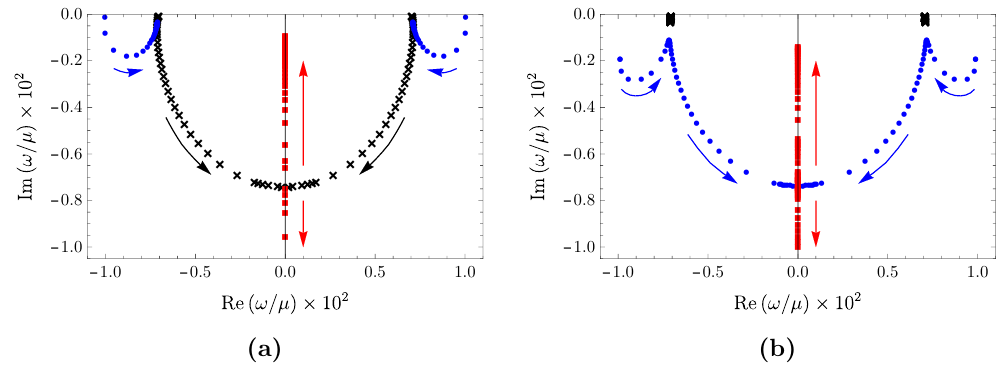
Figure 3. Positions of poles of G J and G tt in the complex !=(cid:22) plane for increasing T=(cid:22) , with ~ (cid:11) = 1 and k=(cid:22) = 10 (cid:0) 2 . We have enhanced Re ( !=(cid:22) ) and Im ( !=(cid:22) ) by 10 2 for clarity. The arrows indicate the movement of poles as T=(cid:22) increases. (a) (cid:28) = 0 and 5 (cid:2) 10 (cid:0) 4 (cid:20) T=(cid:22) (cid:20) 0 : 1. At T=(cid:22) = 5 (cid:2) 10 (cid:0) 4 we (cid:12)nd four poles, two only in G tt , with relativistic dispersion (blue dots), and two only in G J , with dispersion well-approximated by the HZS dispersion in eqs. (3.1) and (3.2) (black crosses). As T=(cid:22) increases the blue dots move down and then back up, eventually becoming hydrodynamic sound poles. The black crosses move down and eventually collide and split on the imaginary axis, producing two purely imaginary poles (red squares), one of which moves up and becomes the charge di(cid:11)usion pole (see also (cid:12)gure 2a). (b) (cid:28) = 10 (cid:0) 4 and 10 (cid:0) 4 (cid:20) T=(cid:22) (cid:20) 0 : 05. At T=(cid:22) = 10 (cid:0) 4 we again (cid:12)nd four poles, similar to (cid:28) = 0, however now all poles are shared by G J and G tt , and the black crosses denote sound poles which persist mostly unchanged as T=(cid:22) increases, while the poles with relativistic dispersion collide and split on the imaginary axis, producing the charge di(cid:11)usion pole. (Animated versions of both (cid:12)gures are available on this paper’s arxiv page.)